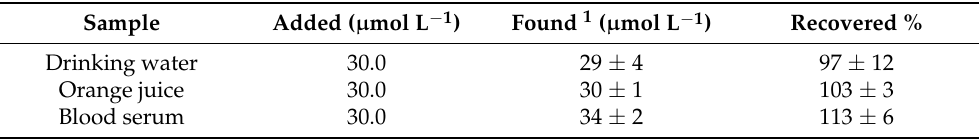
Table 3. Results obtained in the determination of paraquat in water, orange juice, and biological serum samples using the proposed method using the paper-based silver